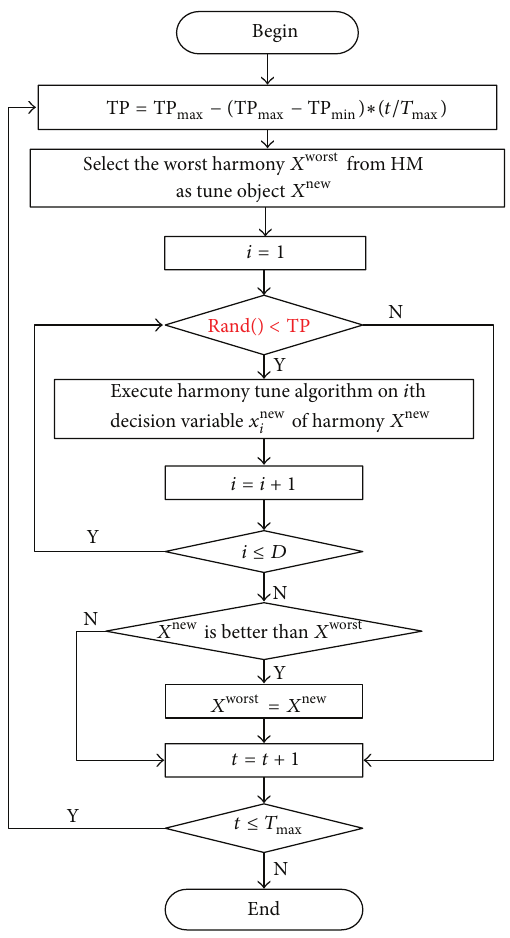
Figure 1: Dynamic dimension selection strategy for HS